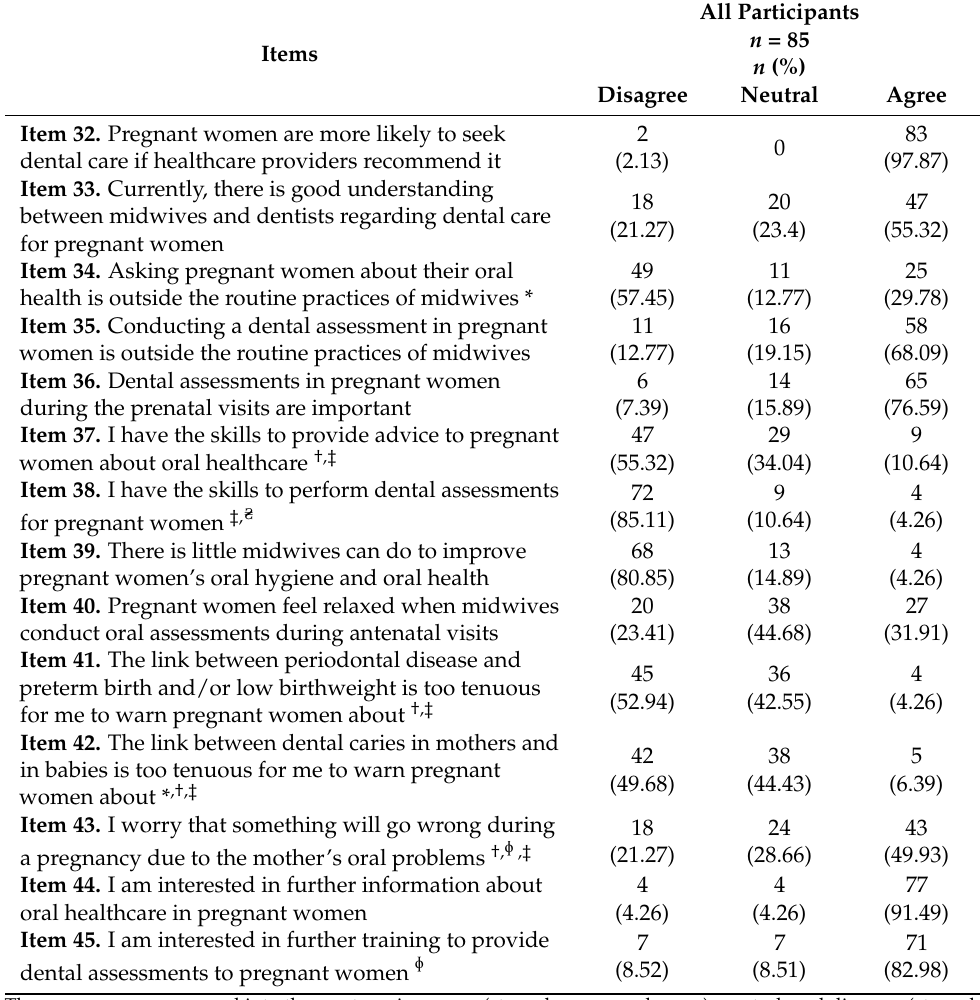
Table 2. Knowledge about oral health during